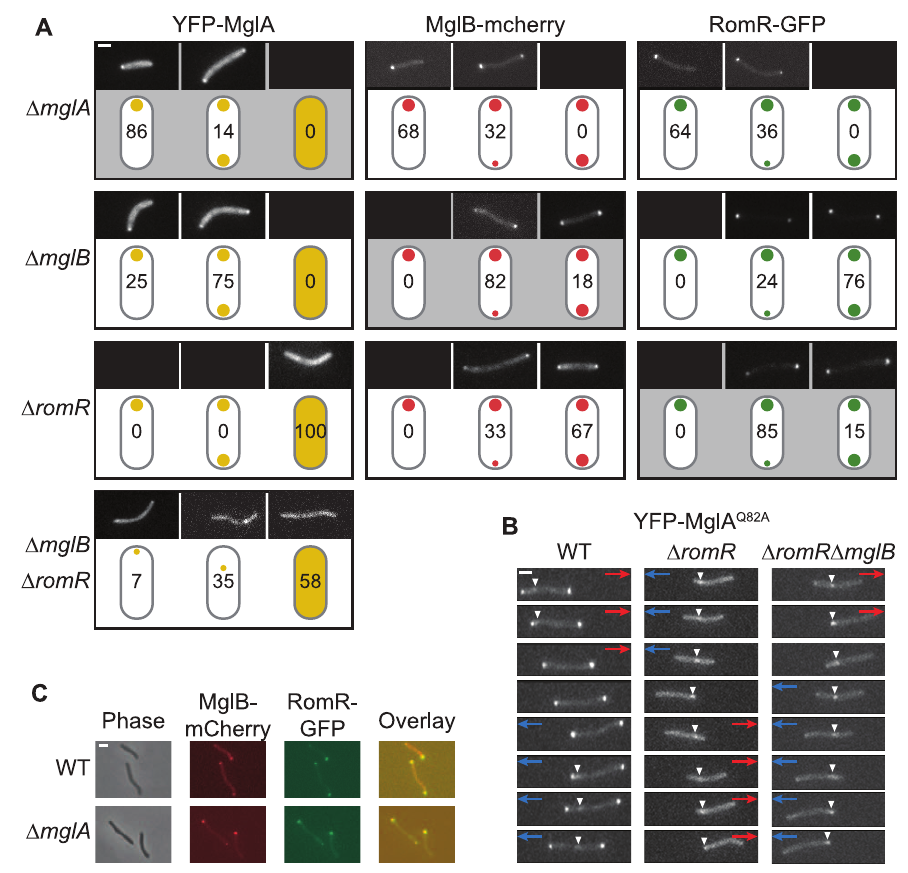
Figure 4. Localization of MglA, MglB, and RomR is mutually dependent. (A) Localization of YFP-MglA, MglB-mCherry and RomR-GFP. Cells were transferred from liquid cultures to a thin agar pad on a microscope slide and imaged by fluorescence microscopy. The localization patterns observed are indicated in the schematics. The ratios between polar signals were calculated to distinguish between unipolar, asymmetric bipolar and symmetric bipolar localization. Schematics highlighted in gray indicate the localization of the fusion proteins in the corresponding in-frame deletion mutants. Representative images of cells are shown for each pattern. Numbers represent % of cells with that pattern. n . 200. Scale bar: 2 m m. (B) Time- lapse microscopy of YFP-MglA Q82A . Cells of the indicated genotypes and producing YFP-MglA Q82A were treated as in (A) and imaged by time-lapse fluorescence microscopy at 30-s intervals. Red and blue arrows indicate opposite directions of movement. White arrowheads indicate the oscillating cluster formed by YFP-MglA Q82A . Scale bar: 2 m m. (C) MglB and RomR colocalize. Cells expressing MglB-mCherry and RomR-GFP were treated as in (A). Right column, overlay of RomR-GFP and MglB-mCherry. Scale bar: 2 m m.